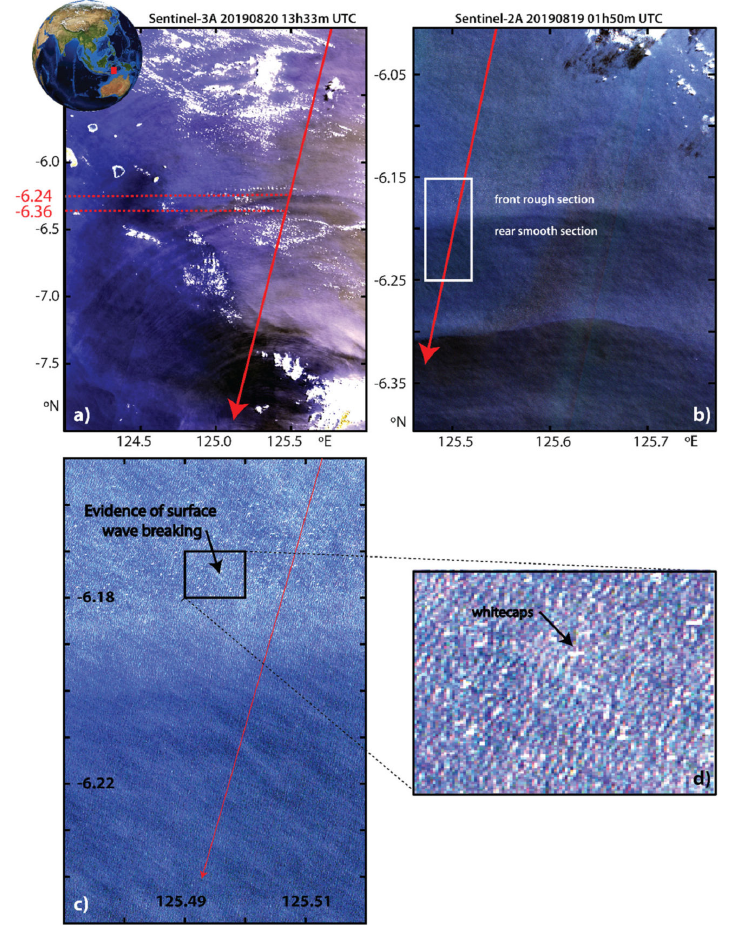
Figure 2. ( a ) Quasi-true color image (Level-1b) acquired on 20 August 2019 at 13 h 33 m UTC by the OLCI sensor onboard the Sentinel-3A satellite (see inset for location). The red line represents the ground-track of the satellite, which in this case is close to the ISWs’ direction of propagation. ( b ) Image taken in the visible band by the Multispectral Instrument (MSI) onboard the Sentinel-2A satellite on 19 August 2019 at 01:50 UTC showing sea surface signatures of an ISW packet. Note the bright spots aligned in bands, which are evidence of whitecaps generated by breaking surface waves. The red line represents the ground-track of the satellite Sentinel-3, approximately one day after. ( c ) Zoom of the Sentinel-2 image in ( b ), in the location of the white rectangle. A larger zoom is also displayed in ( d ), representing the black rectangle in full resolution, and showing